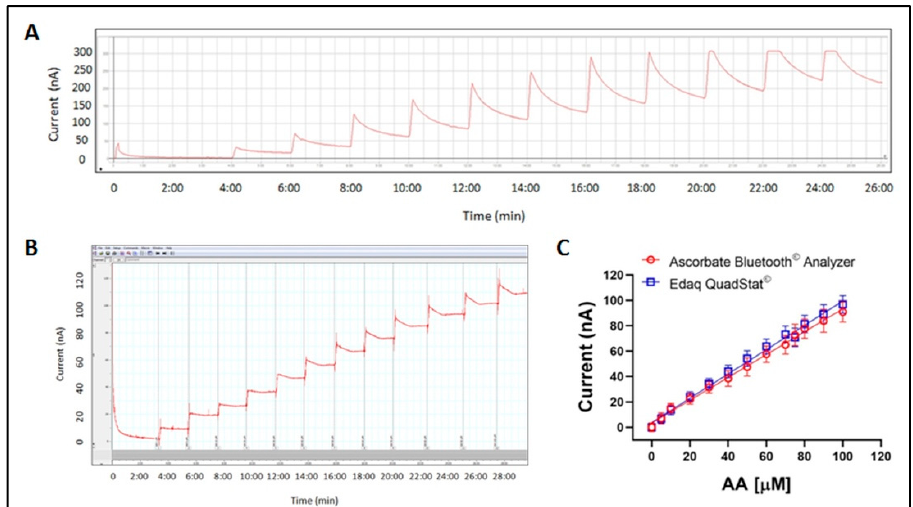
Figure 1. In vitro calibration of AA performed with ABA ( A ) and Quadstat ( B ), respectively. AA regression lines with the two systems starting from 0 up to 100 μ M ( C ). Values are means ± standard deviation, n = 4.